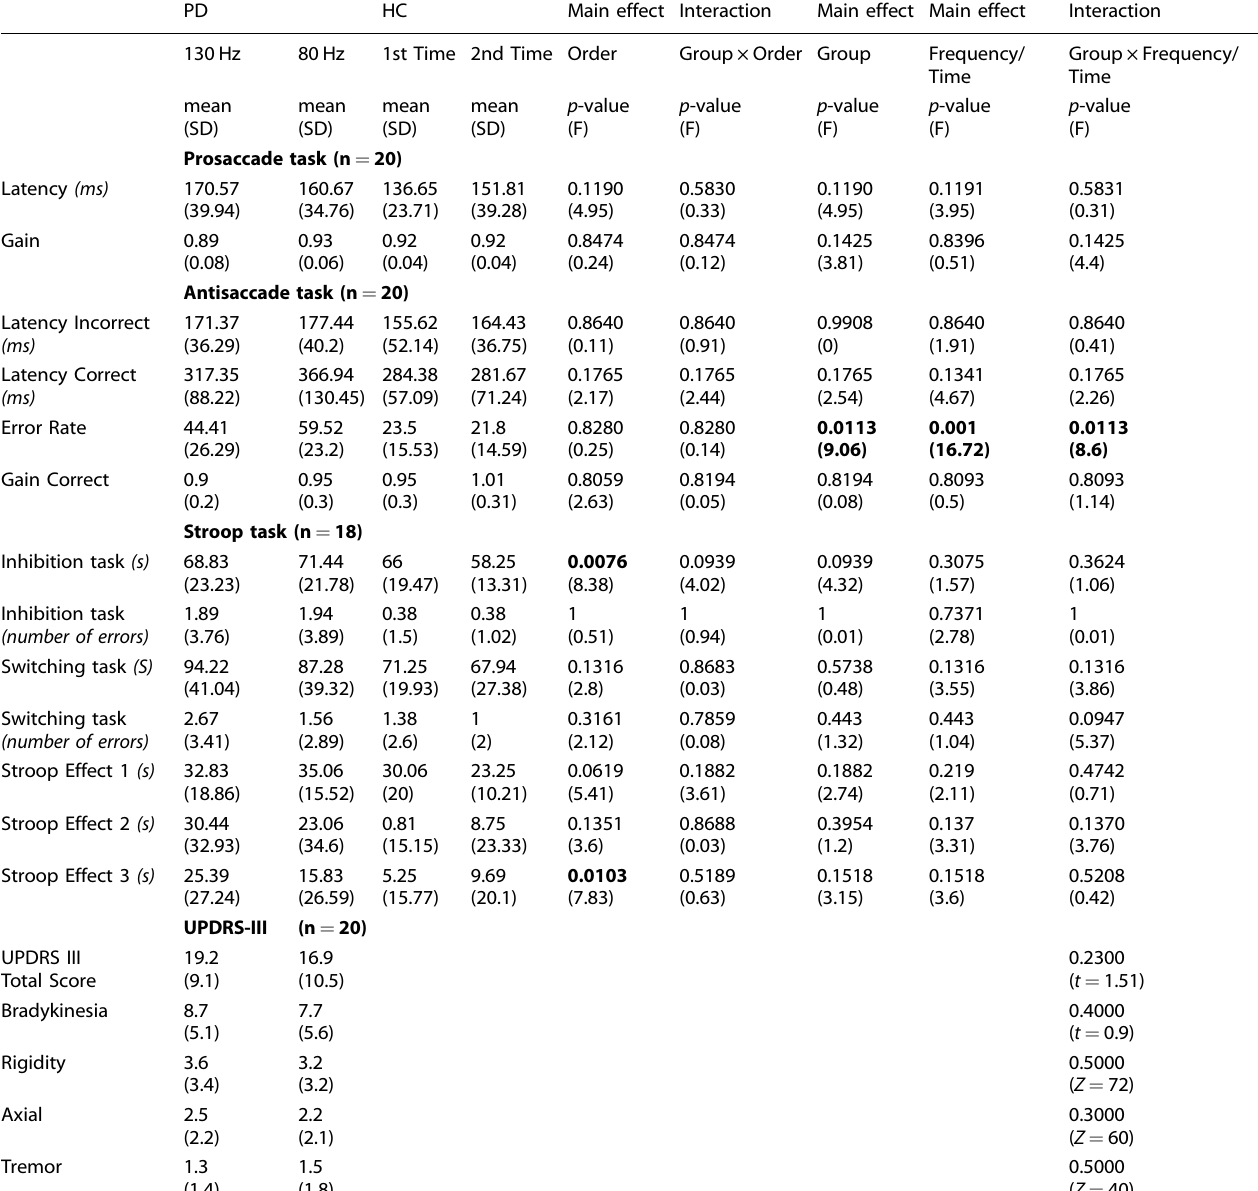
Table 1. The means and standard deviations (SD, in parentheses) of the prosaccade, antisaccade, and Stroop task measurements for Parkinson ’ s disease patients (PD) at 130 and 80 Hz stimulation frequencies and for the healthy controls (HC) on the two days and the results of the generalized mixed-effects model (F) for repeated measures are shown.